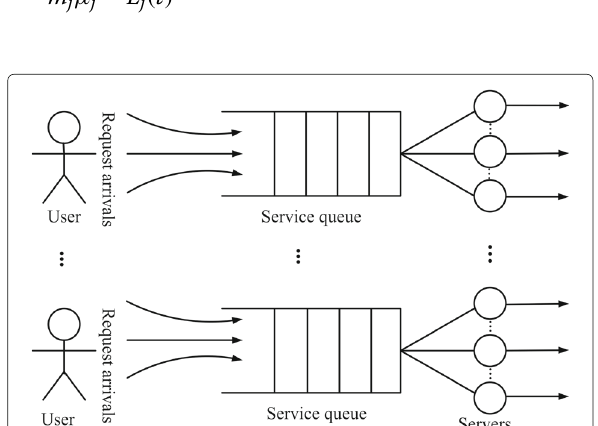
Fig. 3 An M/M/N queueing